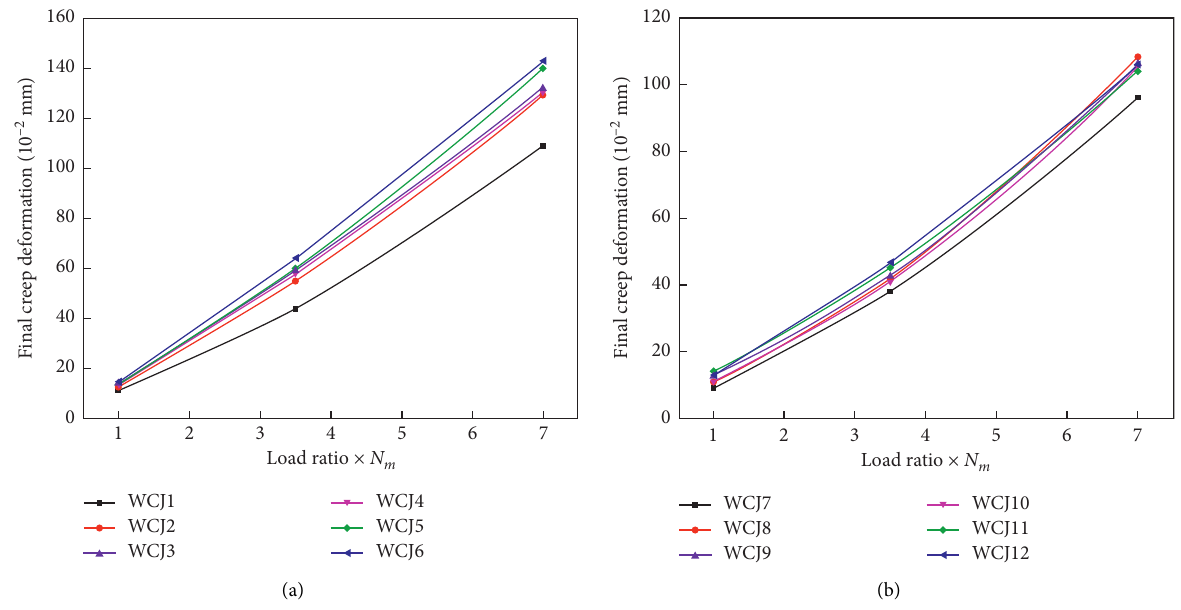
Figure 17: Final creep deformations of interfaces for (a) left anchor and (b) right anchor.